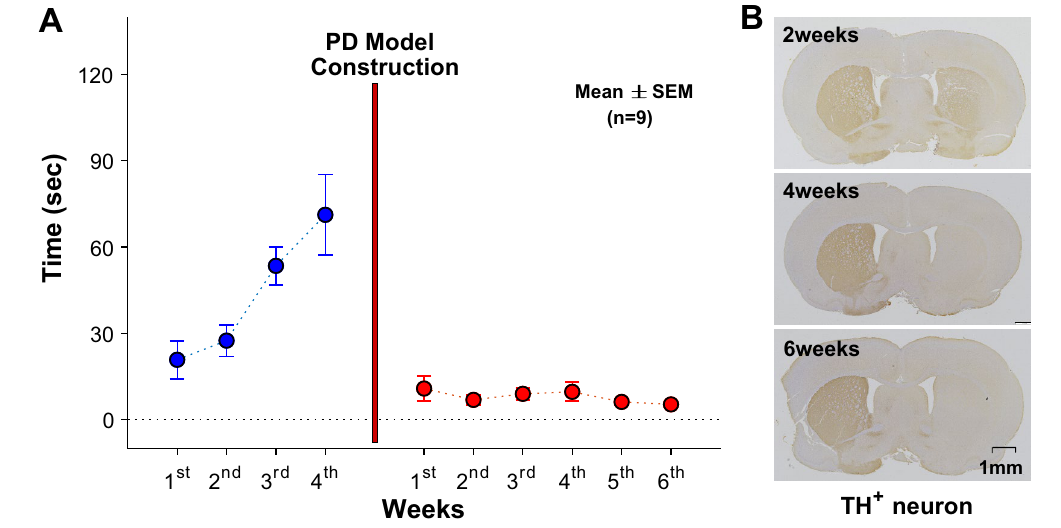
Figure 2. Locomotion activity in time (sec) ( A ) and loss of TH + neurons in striatum (STR) in 2, 4, and 6 weeks after the injection of 6-OHDA ( B ). The performance of locomotion increases, but it decreases after the model construction. The immunoreaction to 6-OHDA in STR shows the TH + neurons are reduced depending on the time elapses (2, 4, and 6 weeks). Again, the decreased TH + neurons are observed only in the right side of 6-OHDA injection. (blue & red circles for normal animals and PD models,